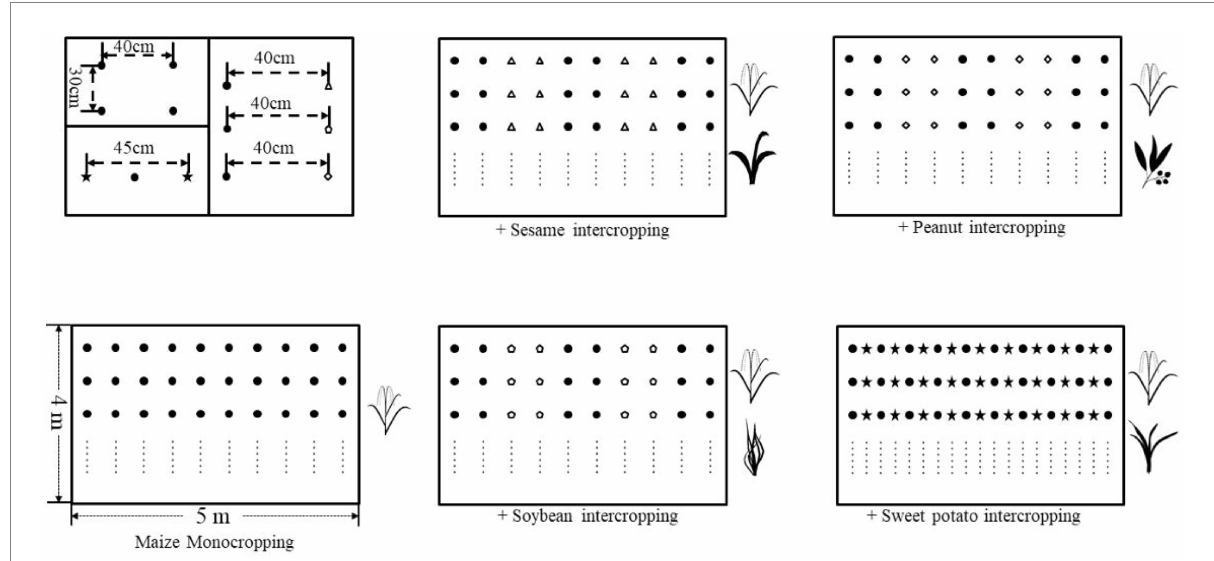
FIGURE 1 Schematic representation of field experimental setups in this study. The cropping patterns were consisted of the monocropping of maize and its four intercropping systems with sesame, peanut, soybean, and sweet